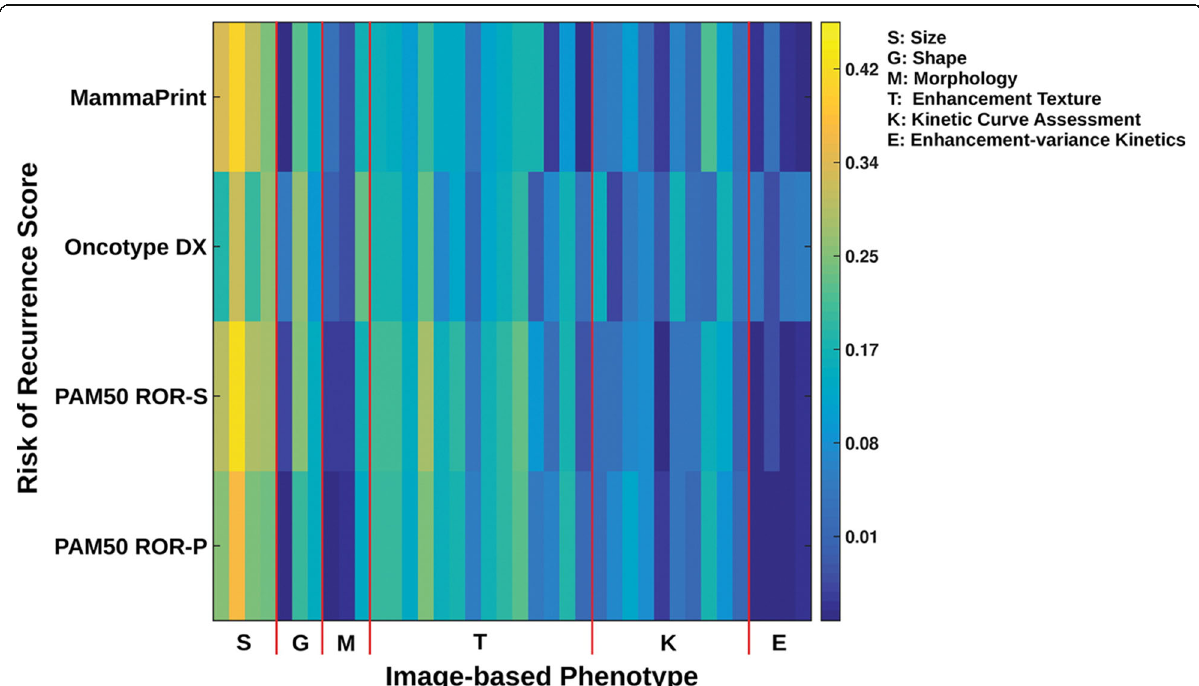
Fig. 3 Correlation heat map based on univariate linear regression analysis between each individual MR imaging phenotype and the recurrence predictor models of MammoPrint, Oncotype DX, PAM50 ROR-S, and PAM50 ROR-P. In this color scale, yellow indicates higher correlation as compared with blue and the different gene assays served as the “ reference standard ” in this study. Some phenotypes correlate similarly (i.e., similar color on the color scale) across the risk estimate models, while others do not. Reprinted with permission from: Radiology. 2016 Nov;281 [2]:382 – 391. Epub 2016 May 5. MR Imaging Radiomics Signatures for Predicting the Risk of Breast Cancer Recurrence as Given by Research Versions of MammaPrint, Oncotype DX, and PAM50 Gene Assays. Li H, Zhu Y, Burnside ES, Drukker K, Hoadley KA, Fan C, Conzen SD, Whitman GJ, Sutton EJ, Net JM, Ganott M, Huang E, Morris EA, Perou CM, Ji Y, Giger